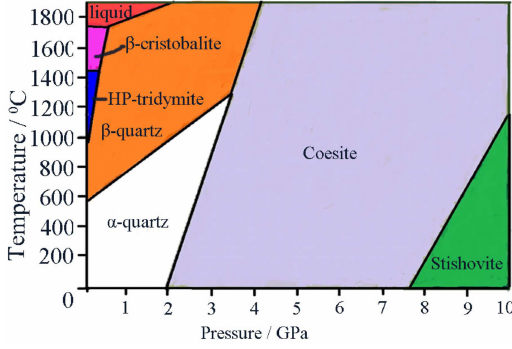
Figure 3. The variants for SiO 2